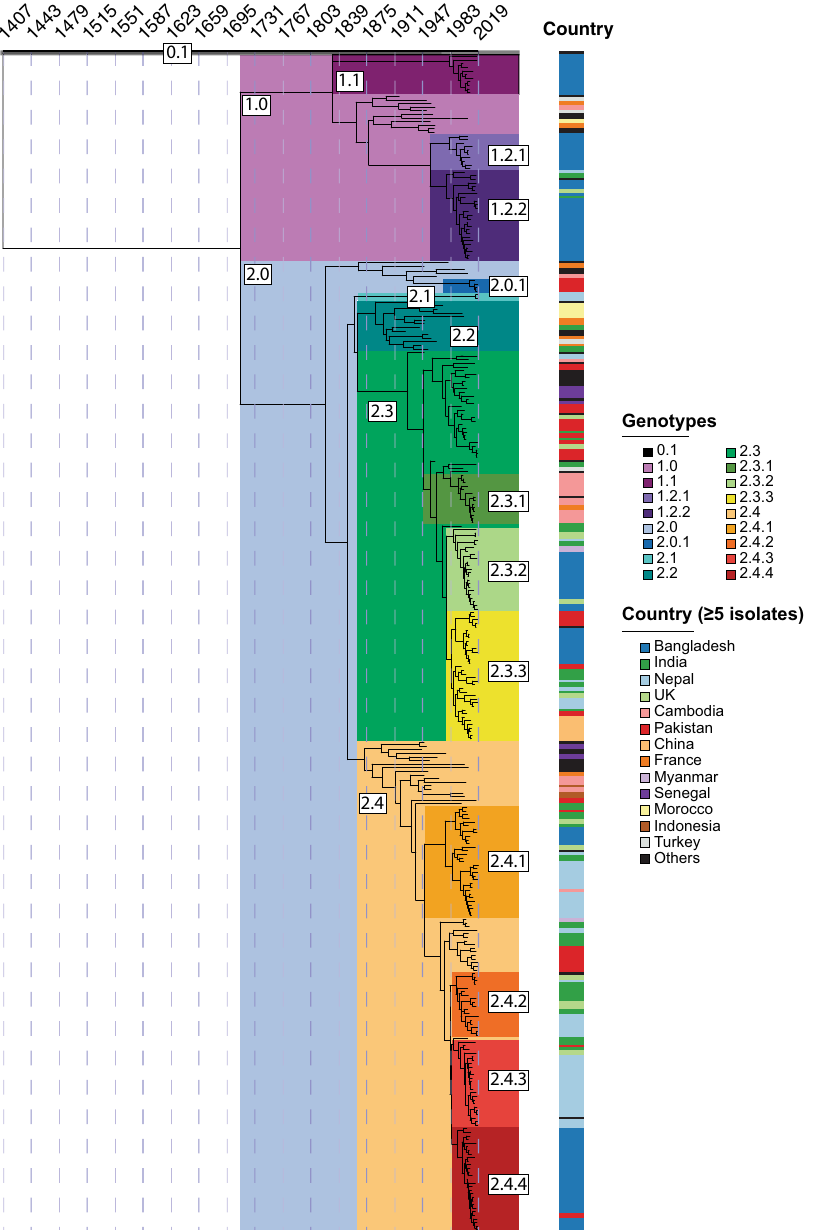
Fig. 2 | Maximum clade credibility tree of 315 representative Salmonella Para- typhi A isolates. The tree shows the last common ancestor of all Salmonella Paratyphi A existed at least 600 years ago (tMRCA − 1407 AD). The different